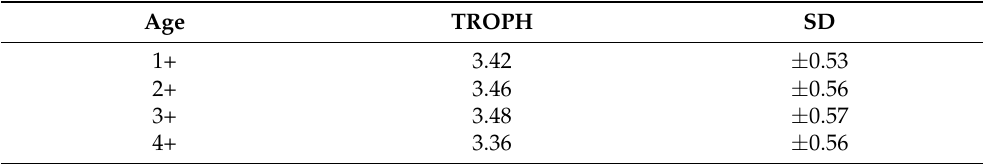
Table 7. Trophic level (TROPH) of different age groups of S. scriba